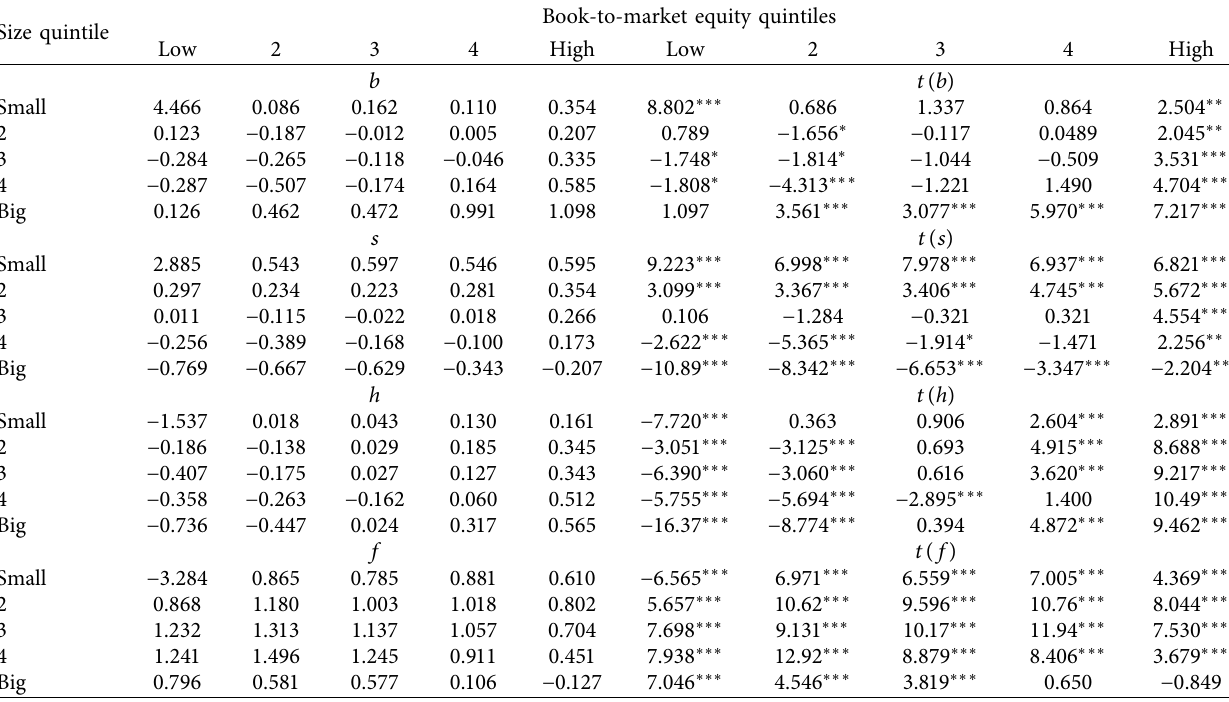
Table 3: Grouped regression results of the multilayer network risk factor pricing model. Book-to-market equity quintiles Size quintile